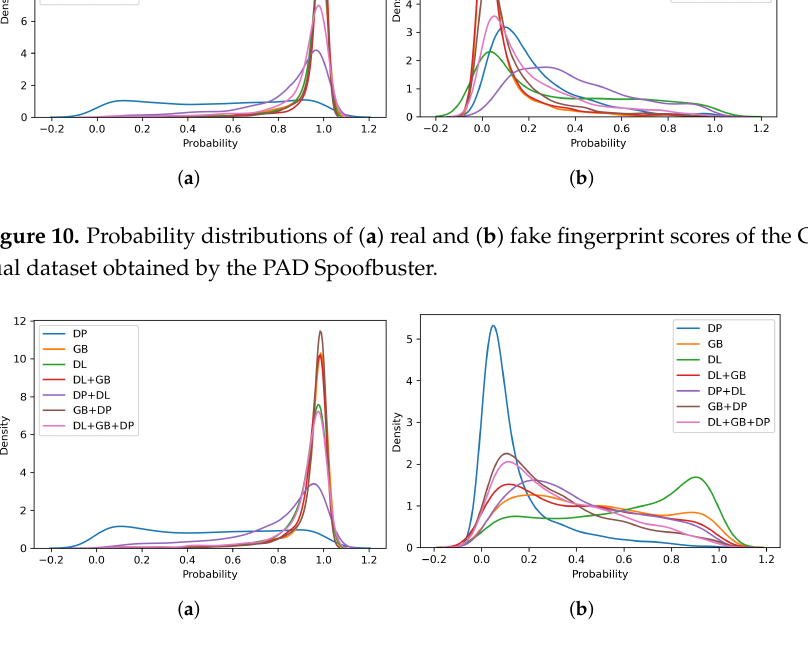
Figure 11. Probability distributions of ( a ) real and ( b ) fake fingerprint scores of the GreenBit Screen- Spoof dataset obtained by the PAD Spoofbuster.